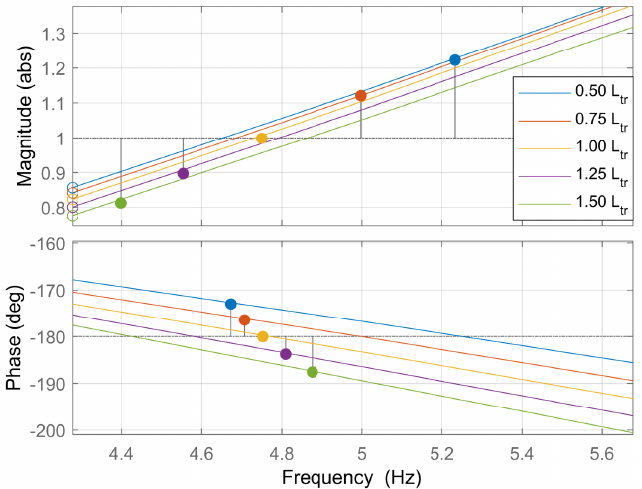
Figure 12. Bode diagram of the system eigenvalue λ 1 . Variation of leakage inductance.